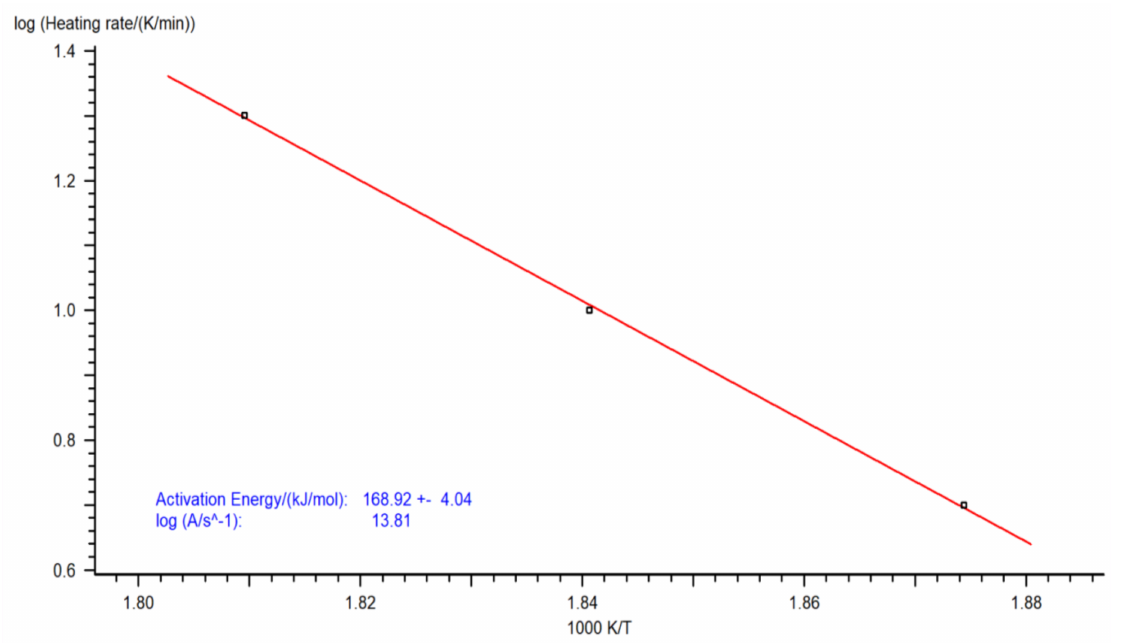
Figure A2. Kissinger analysis (ASTM E698) for sewage